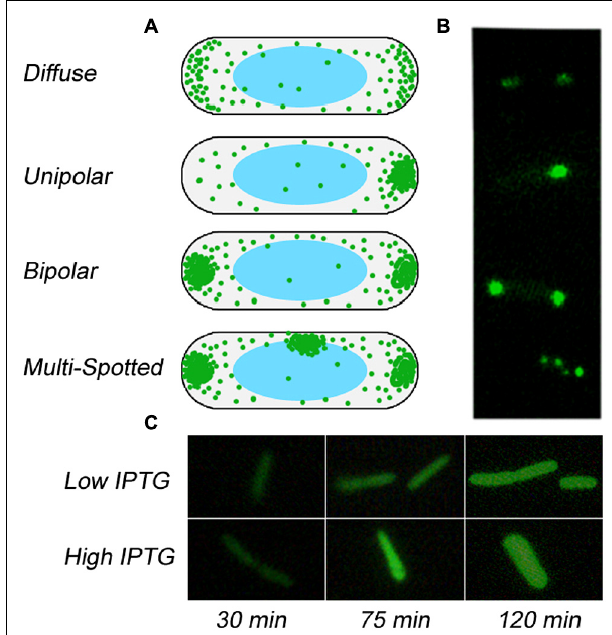
FIGURE 1 | Possible patterns of localization of aggregates in Escherichia coli. (A) Schematics of the various patterns of aggregating proteins inside a bacterial volume, from diffuse to unipolar to bipolar to multispot. (B) Representative images of GFP-tagged protein showing the corresponding localization pattern as depicted in (A) . (C) Localization of GFP-tagged protein in filamentous